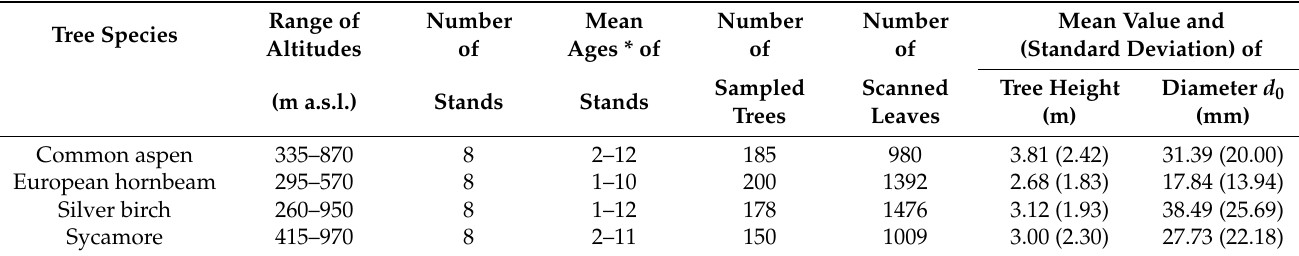
Table 6. Main characteristics on sampled locations, sampled trees and scanned leaves for individual investigated tree